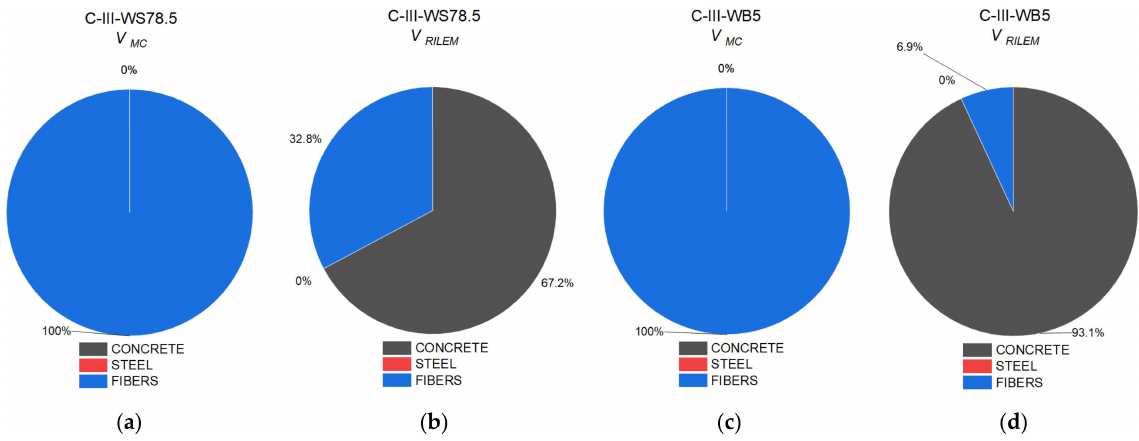
Figure 14. Proportion of the individual components of shear capacity of beams in the following series: ( a ) C-III-WS78.5 pursuant to fib Model Code 2010; ( b ) C-III-WS78.5 pursuant to RILEM TC 162-TDF 2003; ( c ) C-III-WB5 pursuant to fib Model Code 2010; ( d ) C-III-WB5 pursuant to RILEM TC 162-TDF